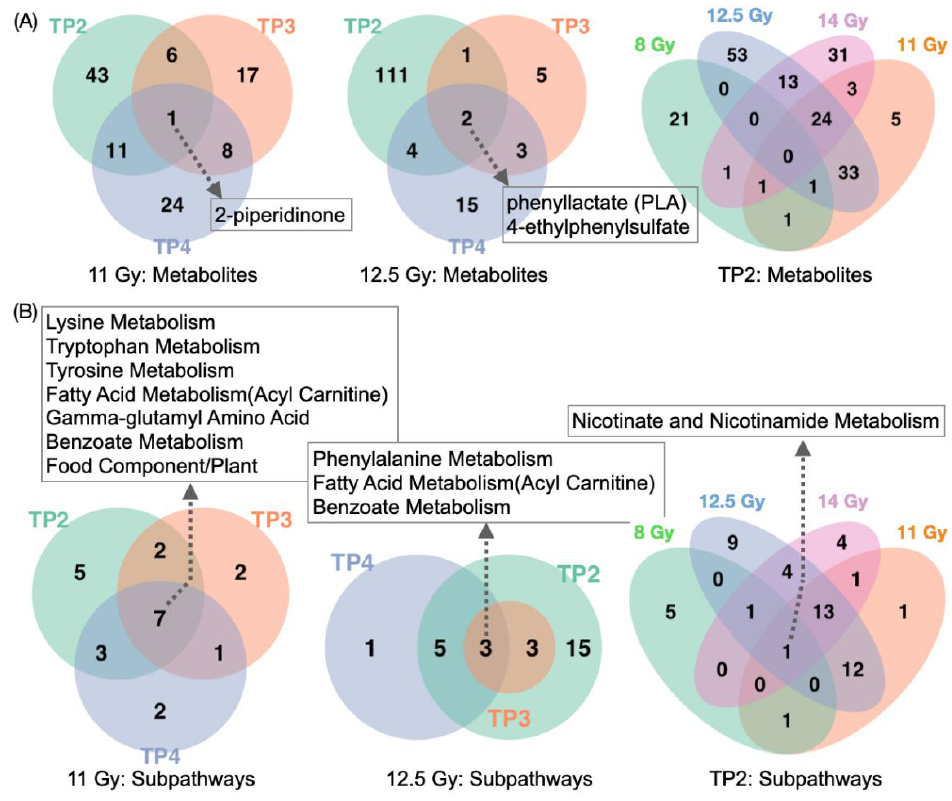
Figure 2. Venn diagrams highlighting common and distinct significantly dysregulated ( A ) metabolites and ( B ) subpathways, where metabolites and subpathways were excluded if they were also identified as markers for 0 Gy indicating non-radiation-induced markers. For both ( A , B ), comparisons between TP1 and TP2, TP3, TP4 and comparisons between 0 Gy and 8 Gy, 11 Gy, 12.5 Gy, 14 Gy were considered. The four statistical strategies (univariate analysis with p value < 0.05, fold change > 2, OPLS-DA with VIP values > 1, subpathway enrichment analysis with p value < 0.05) were applied to identify significantly dysregulated metabolites and subpathways.